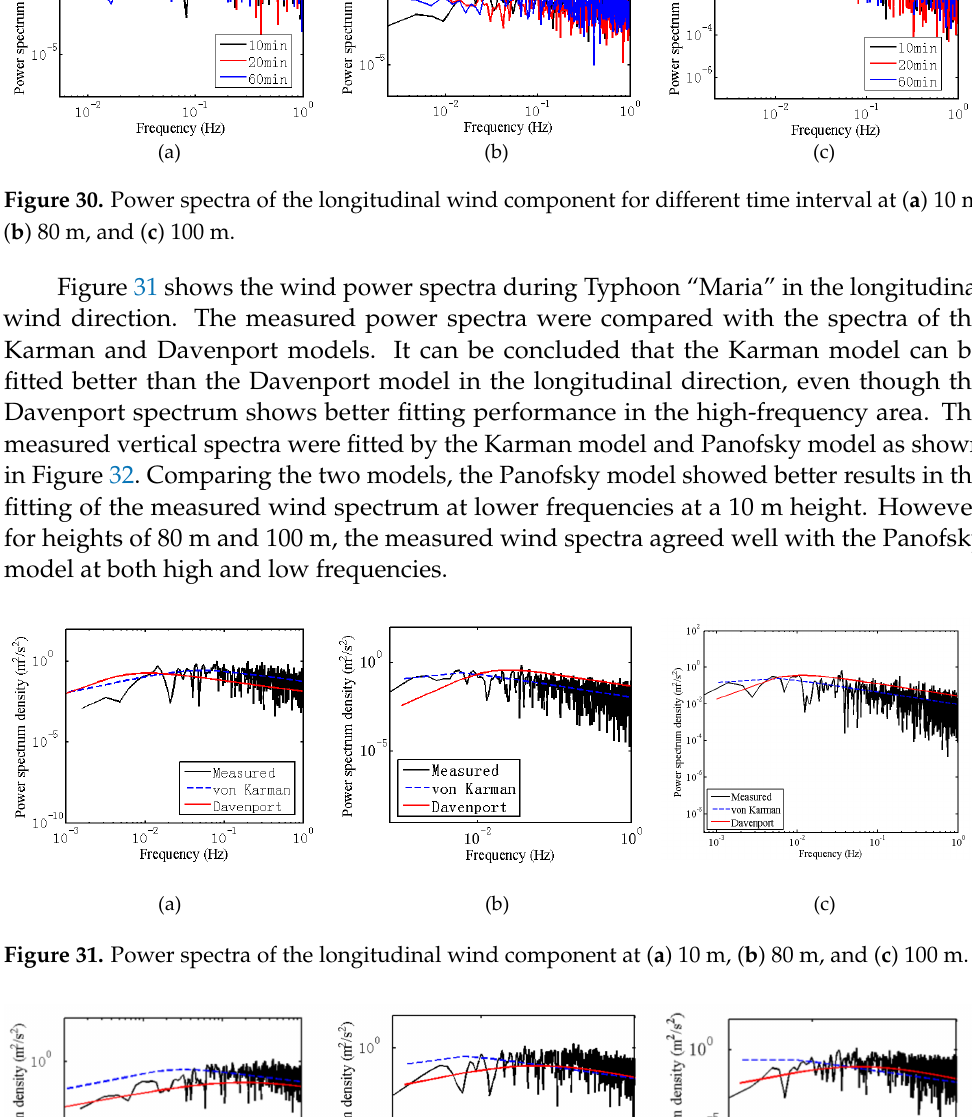
Figure 32. Power spectra of the vertical wind component at ( a ) 10 m, ( b ) 80 m, and ( c ) 100 m. Figure 31. Power spectra of the longitudinal wind component at ( a ) 10 m, ( b ) 80 m, and ( c ) 100 m.